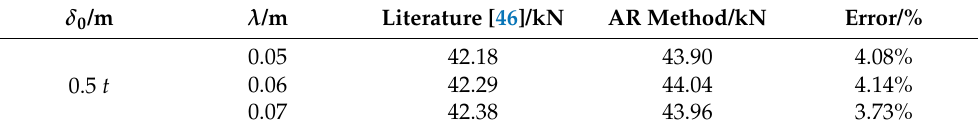
Table 5. Comparison of post-buckling ultimate loads of cylinders with DI under axial compression.